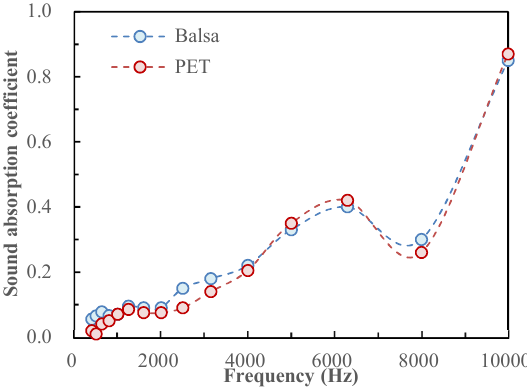
Figure 9. The experimental sound absorption coefficients of balsa and PET foam with frequency.